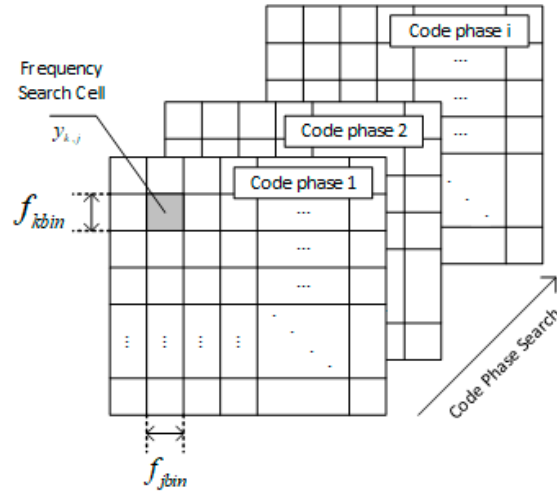
Figure 8. Search space of the proposed algorithm.